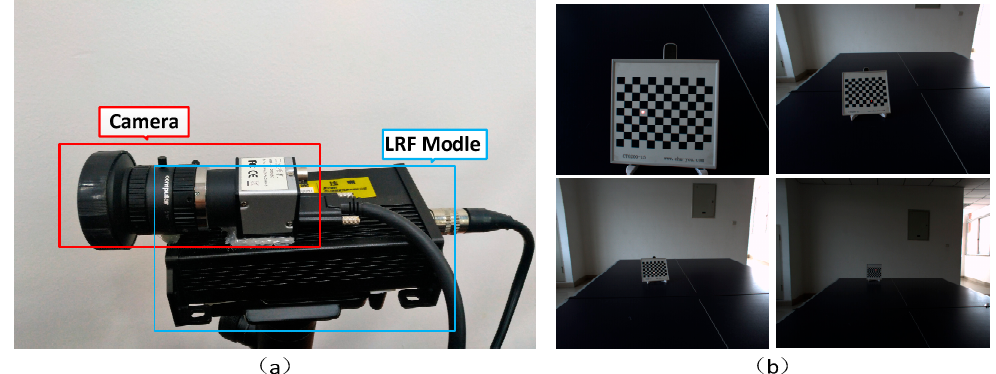
Figure 7. Mono-LRF system and the calibration example. ( a ) Mono-LRF system assembled by the camera and the LRF module; ( b ) Calibration image example for different distances.